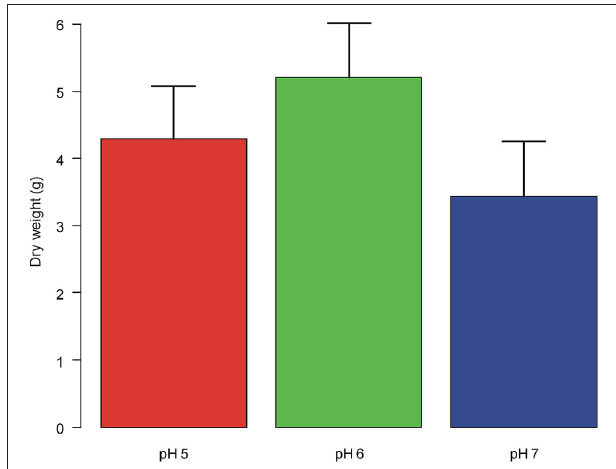
FIGURE 3 | Dry weight of the aerial biomass (means + st. dev.) of A. artemisiifolia under different pH values. No significant differences were detected among the